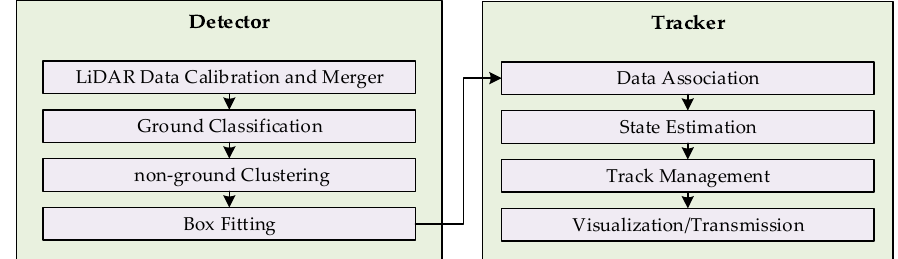
Figure 1. Multiple Object Detection and Tracking Architecture.